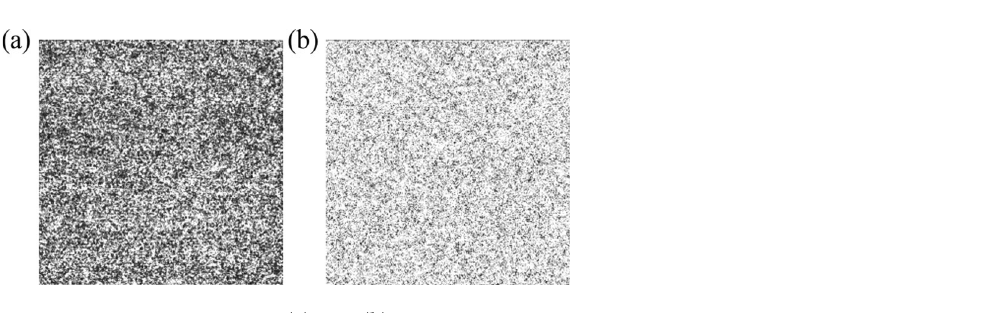
Figure 9. NO 2 response image ( a ) BF1, ( b )